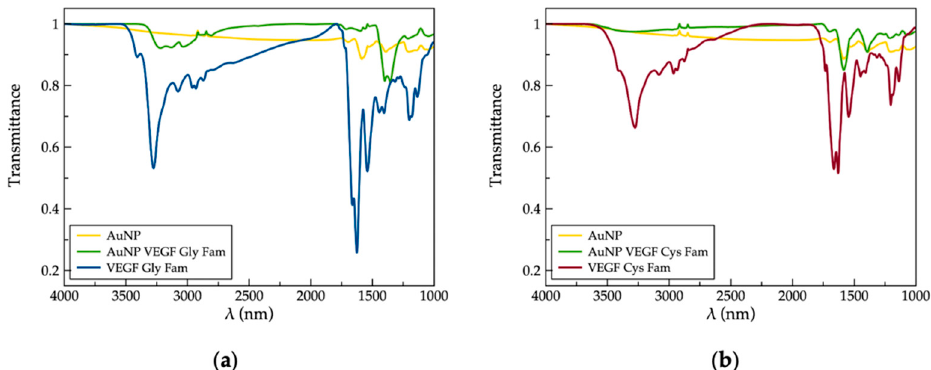
Figure 5. FT-IR spectra of the bare gold nanoparticles (yellow line) and the hybrid (green line) AuNP/VEGF Gly FAM ( a ) or AuNP/VEGF Cys FAM ( b ). The spectra of the free, unbound peptides are included for comparison.